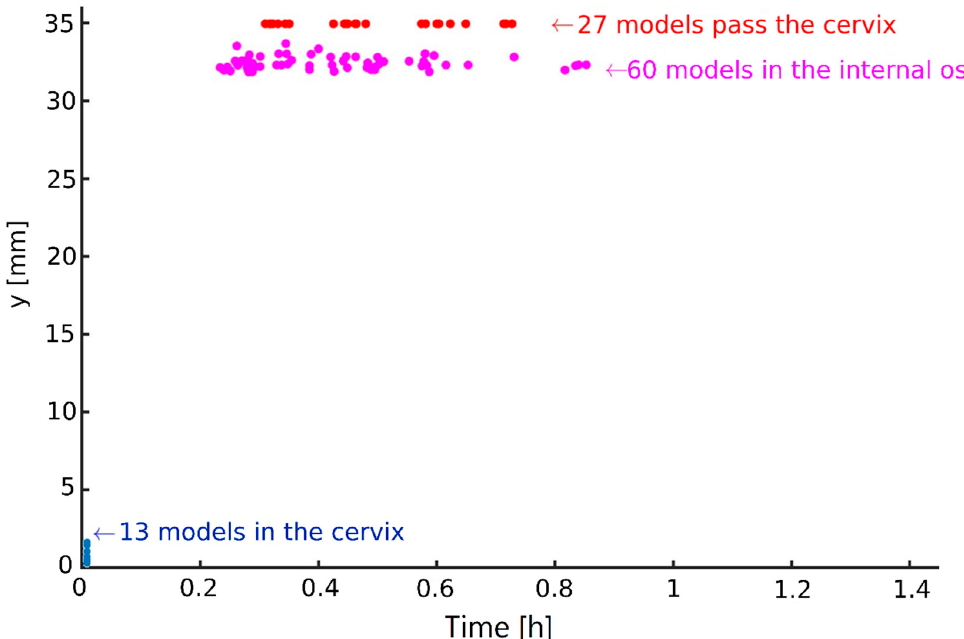
Figure 6. Normal sperm cell models’ behaviors in the cervical canal as a function of time. A total of 27 normal models passed through the cervical canal toward the uterine cavity in less than 0.7 h (red dots); 60 normal models were trapped in the internal os (purple dots); 13 normal models were trapped in the cervical canal (blue dots). Table 2. Time positions (average) of the normal and abnormal models through the human female cervical canal and uterine